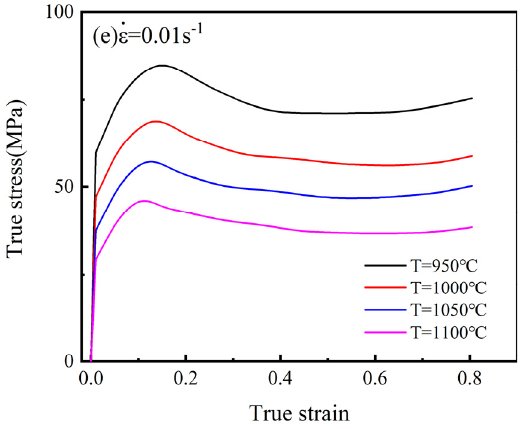
Figure 2. True stress–strain curves at different temperatures and strain rates. ( a ) T = 950 °C; (b) T=1000 °C; ( c ) T = 1100 °C; ( d ) T = 1100 °C; ( e ) ε = 0.01 s − 1